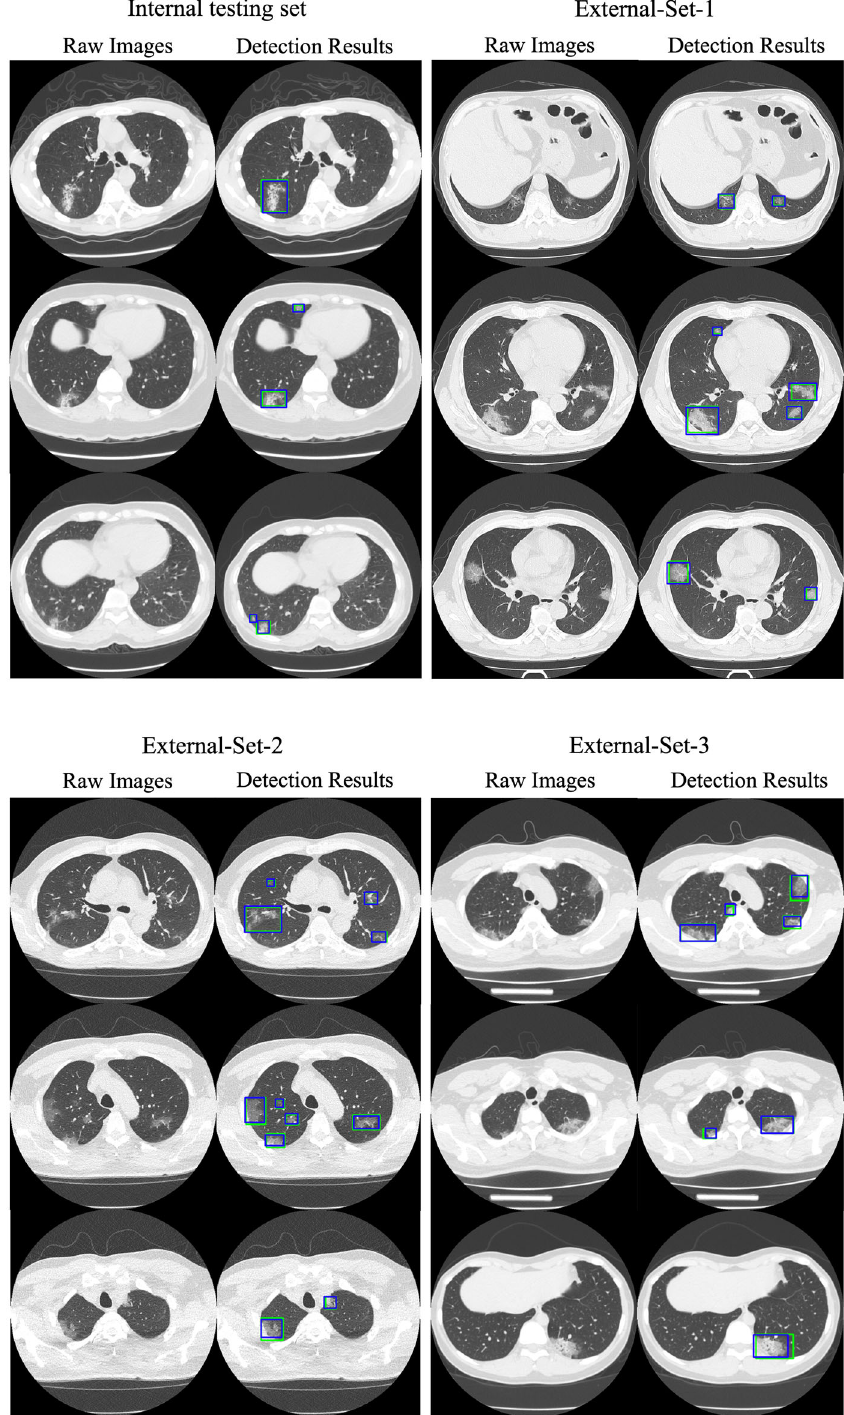
Fig. 3 Qualitative results of lesion detection in COVID-19 CT images using federated learning model on the internal testing set and three external sets. The raw images are shown in par with the detection results indicated by bounding boxes. The blue and green boxes denote the model predictions and manual reference lesion regions,